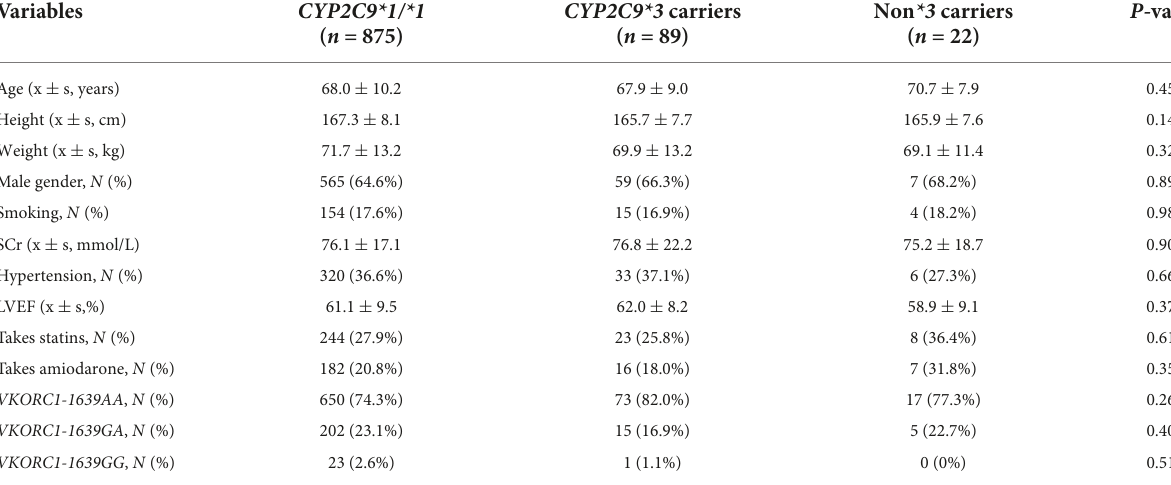
TABLE 3 Baseline characteristics of the study